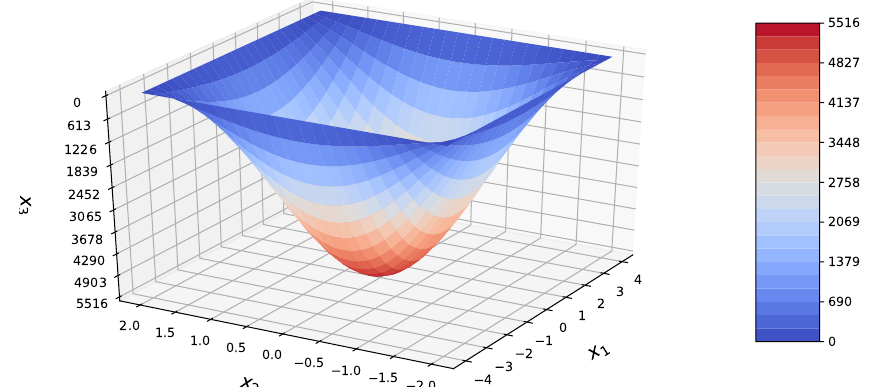
Figure 6. Three-dimensional plot of the bending moment M 22 of a rectangular plate with two opposite edges simply supported and the other free.